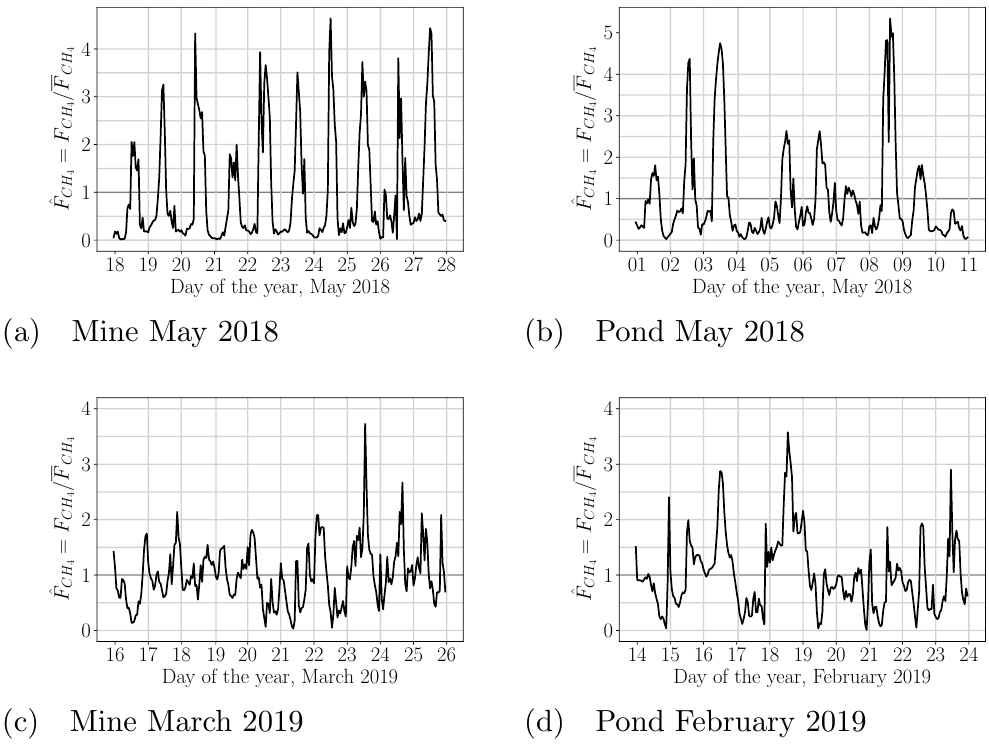
Figure 3. Time series of WRF-simulated normalized advective flux of methane ( ˆ F CH domain (05) boundaries, surrounding the open-pit mining facility; numbers on the horizontal axis indicate the start of day using local standard time (LST = UTC − 7); ( a ) Mine May 2018; ( b ) Pond May 2018; ( c ) Mine March 2019; ( d ) Pond February